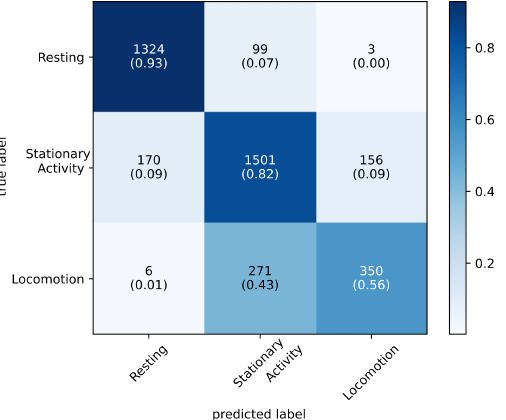
Figure 7. Confusion matrix of the final classification model using all available data points. The numbers in the boxes show the amount of samples. The numbers in brackets below show the relative amount of